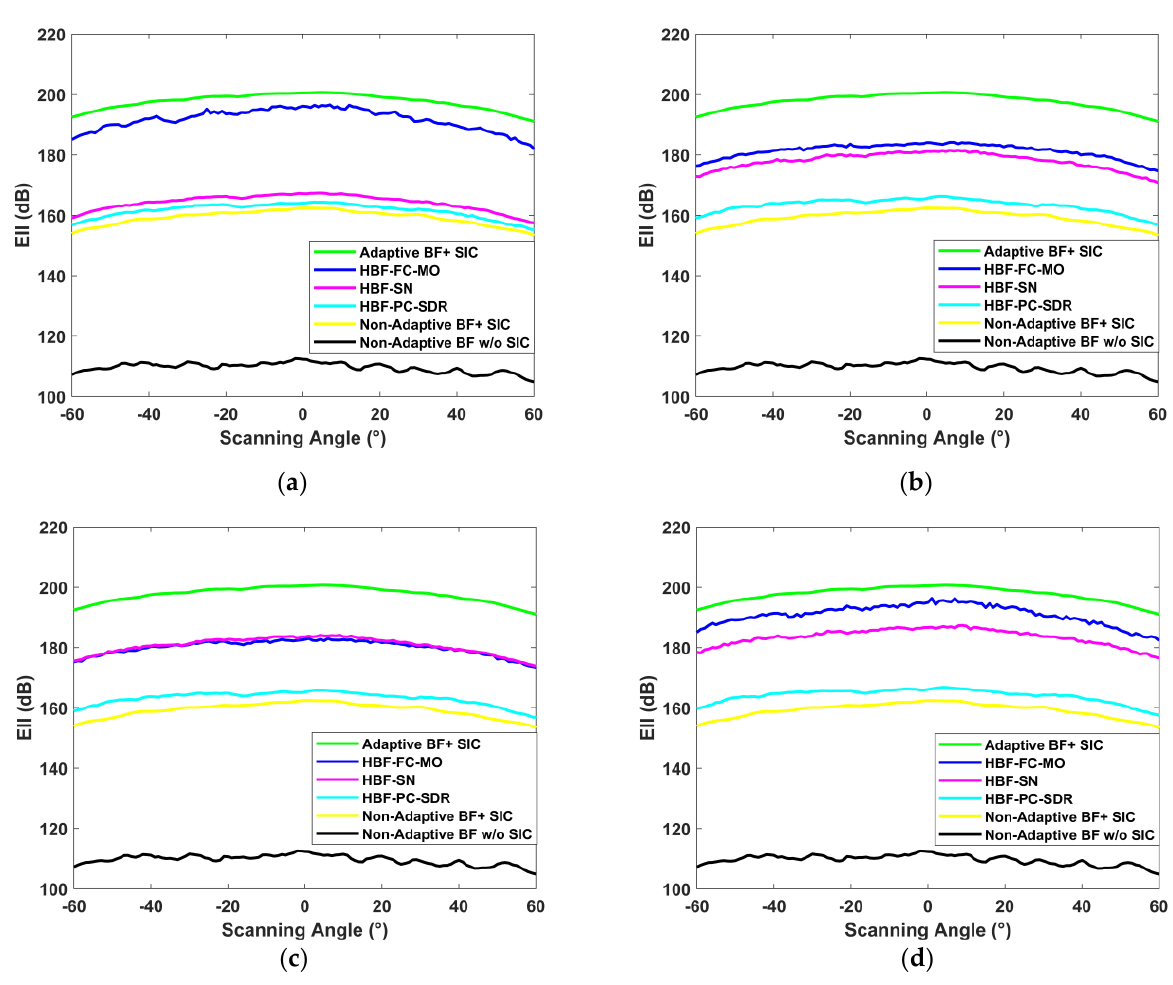
Figure 6. ( a ) 2 N R F = ; ( b ) . 290 Figure 6. ( a ) NRF = 2; ( b ) NRF = 12; ( c ) NRF = 16; ( d ) NRF = Figure 6(a)-(d) compare the system EII of the three categories of simplified structures un- 291 der different RF link conditions. The EII of the HBF-PC-ALSTAR and the HBF-SN-AL- 292